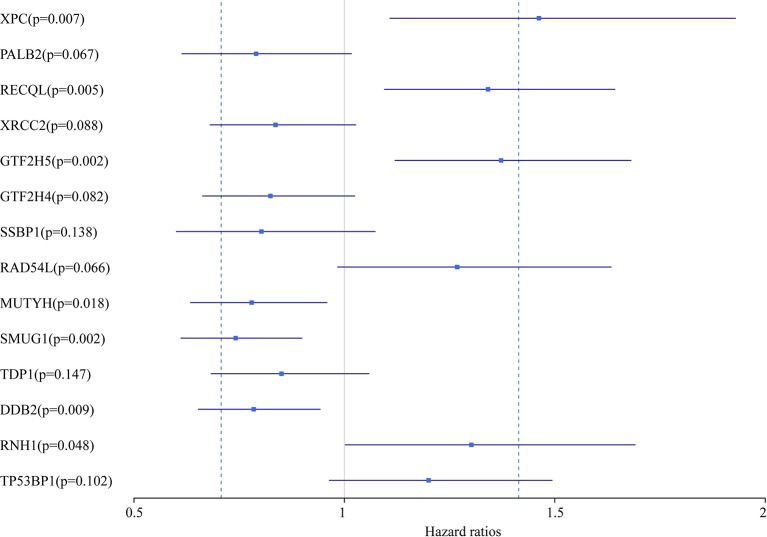
The forest map of 14 DNA repair genes in the prognostic model.